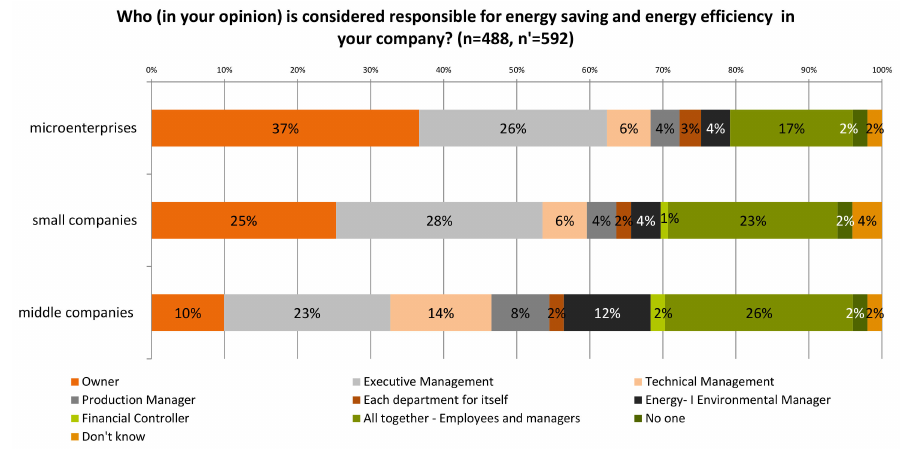
Figure 7. Responsibility for energy saving and energy e ffi ciency in the